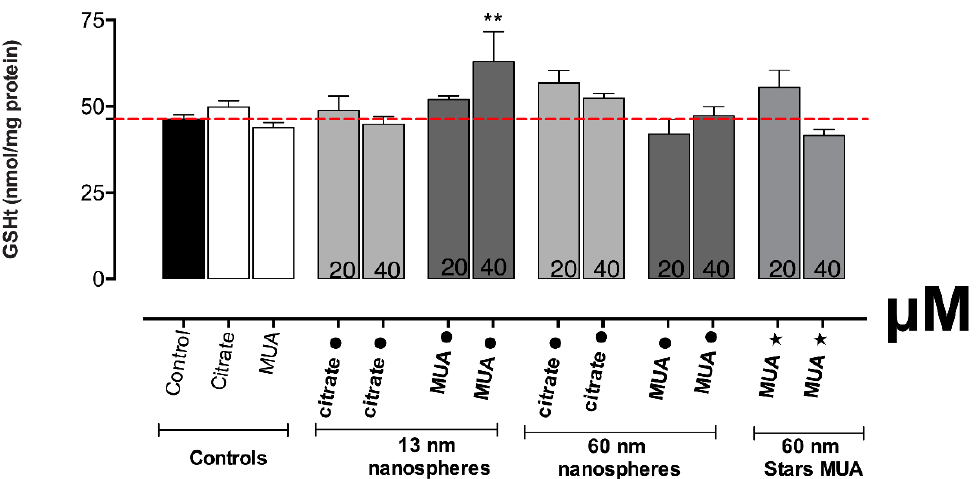
Figure 6. Intracellular contents of total glutathione (GSHt), in HK-2 cells, after 24 h incubations at 37 °C with AuNPs. Results from four independent experiments are expressed as mean ± standard error of the mean (SEM). Statistical comparisons were made using one- way ANOVA/Dunnett’s post hoc test ** p ≤ 0.01; versus control.